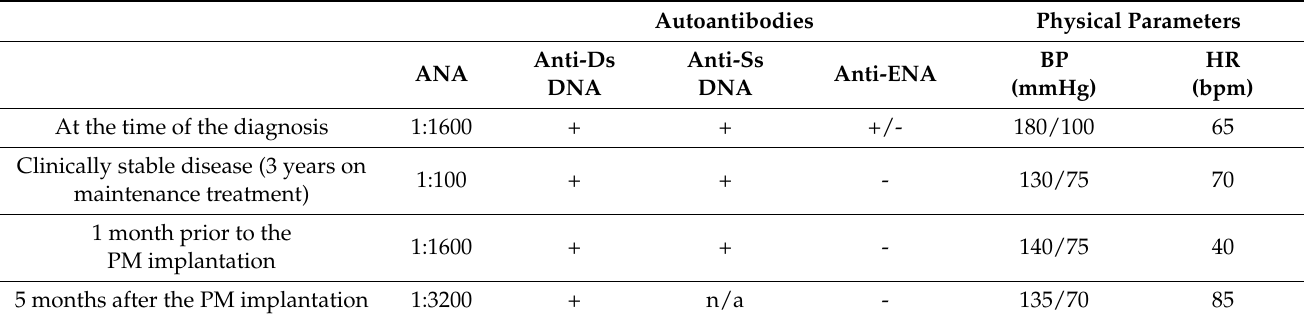
Table 1. Patient’s antibody panel results and physical parameters during treatment periods.